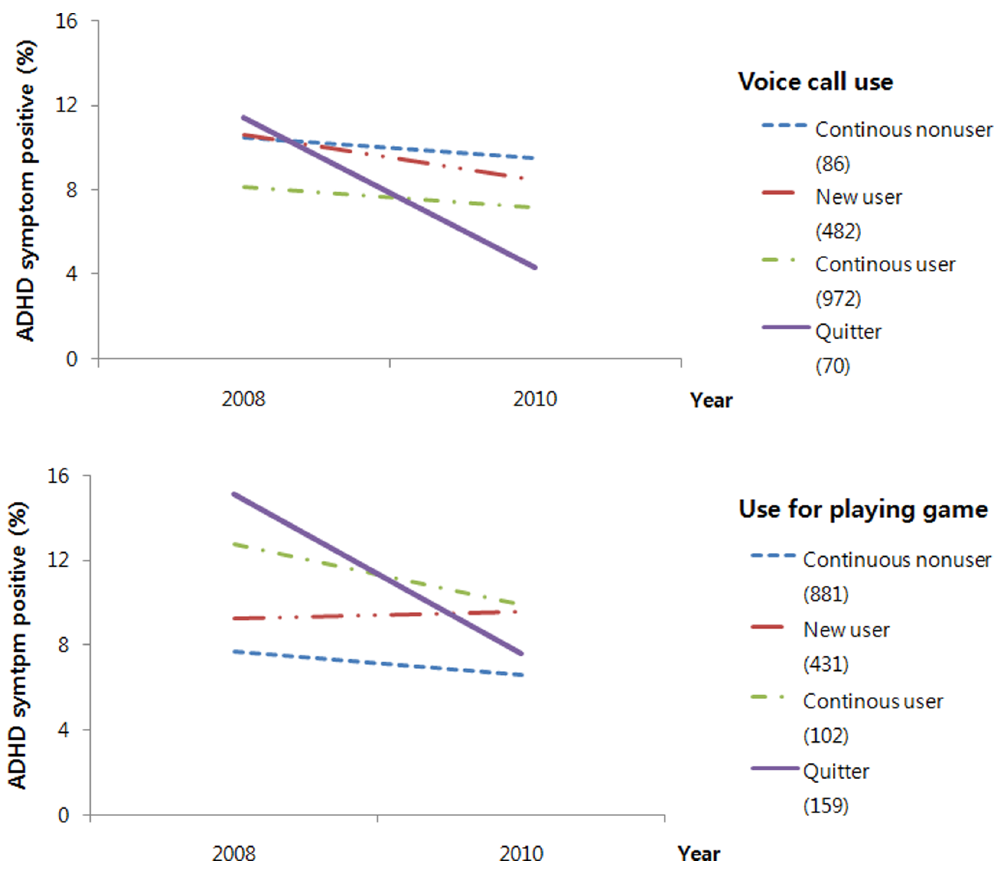
Figure 2. Changes in ADHD symptoms according to the change in mobile phone use for voice calls and playing game over 2 years. Numbers in parentheses are the number of subjects in the corresponding group.